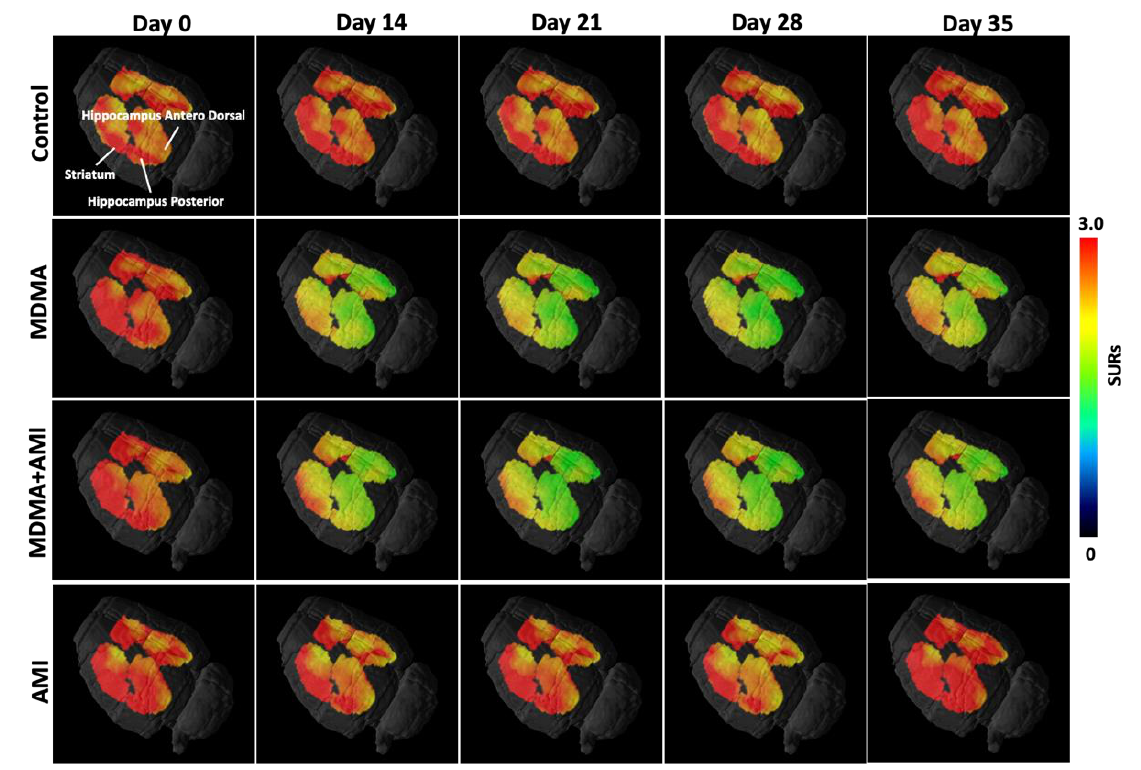
Figure 2. 3D quantitative 4-[18F]-ADAM PET images in different brain areas. 4-[ 18 F]-ADAM binding to SERT in the motor cortex, cingulate cortex, auditory cortex, visual cortex, and thalamus, striatum, hippocampus, and anterodorsal hippocampus. In general, the uptake of 4-[ 18 F]-ADAM in all 9 re- gions was significantly reduced in MDMA group as compared to the controls and was gradually increased from day 14 to day 35 (second row). MDMA with AMI pretreatment demonstrated pro- gressive and significant increase in the uptake of 4-[ 18 F]-ADAM (third row) whereas AMI alone had no effect on the uptake of 4-[18F]-ADAM (fourth row).